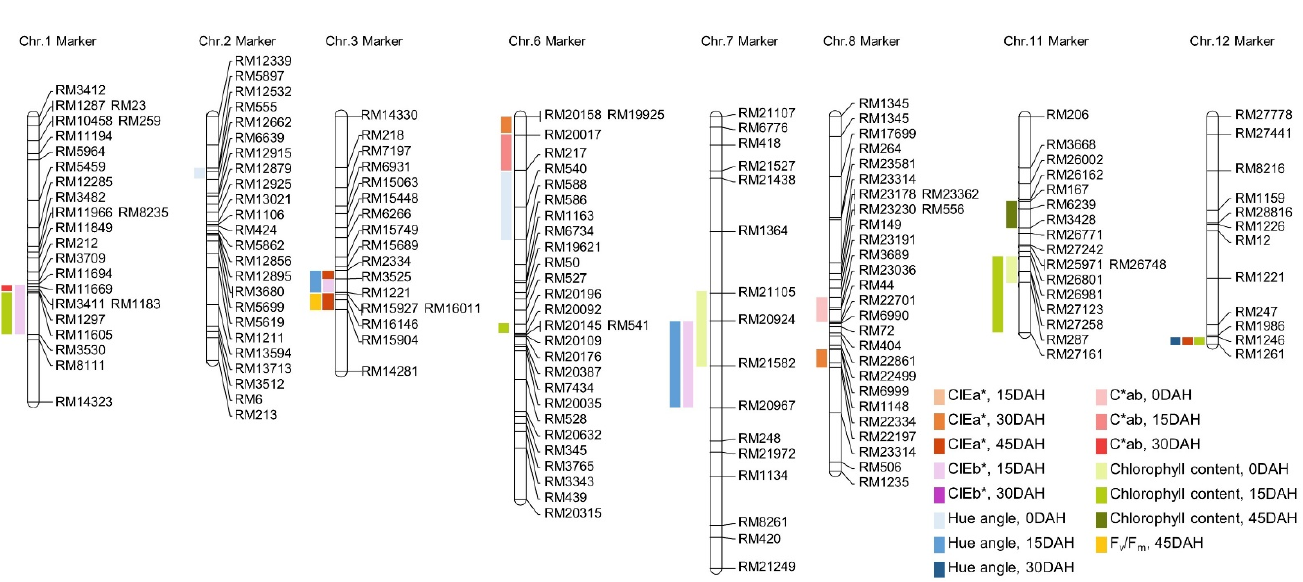
Figure 3. The chromosomal location of QTLs associated with leaf color, chlorophyll content, and F v /F m of CNDH linen. The QTLs are shown by bars on the left side of the chromosome. QTLs related to the CIELAB value were detected in chromosome 1, 2, 3, 6, 7, 8, and 12; QTLs related to chlorophyll content were detected in chromosomes 1, 6, 7, 11, and 12; and QTLs related to F v /F m were detected in chromosome 3. QTLs above the LOD score ≥ 2.5 were commonly detected in RM26981-RM287 on chromosome 11 and RM1246-RM1261 on chromosome 12. Table 3. QTLs related to the photosynthesis efficiency-related traits of CNDH line.